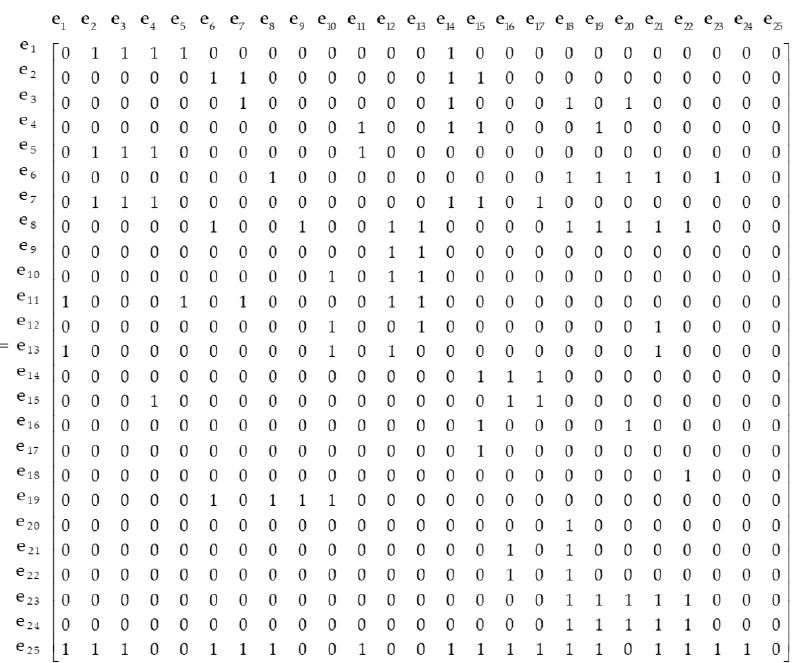
Figure 2. Dominant relationship matrix between indicator elements of community emergency as- sessment.